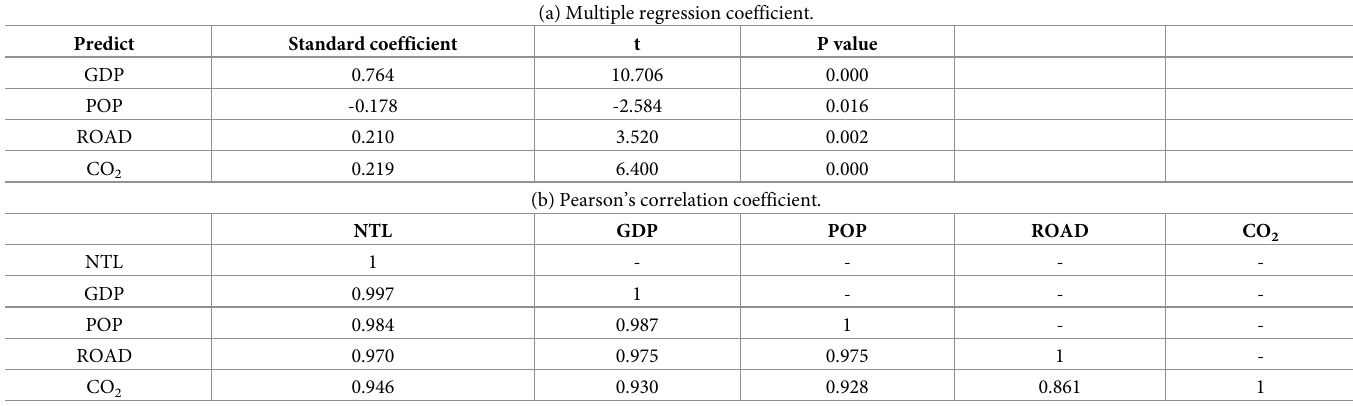
Table 4. Multiple regression coefficient and Pearson’s correlation coefficient of NTL density at provincial level in China. (a) Multiple regression